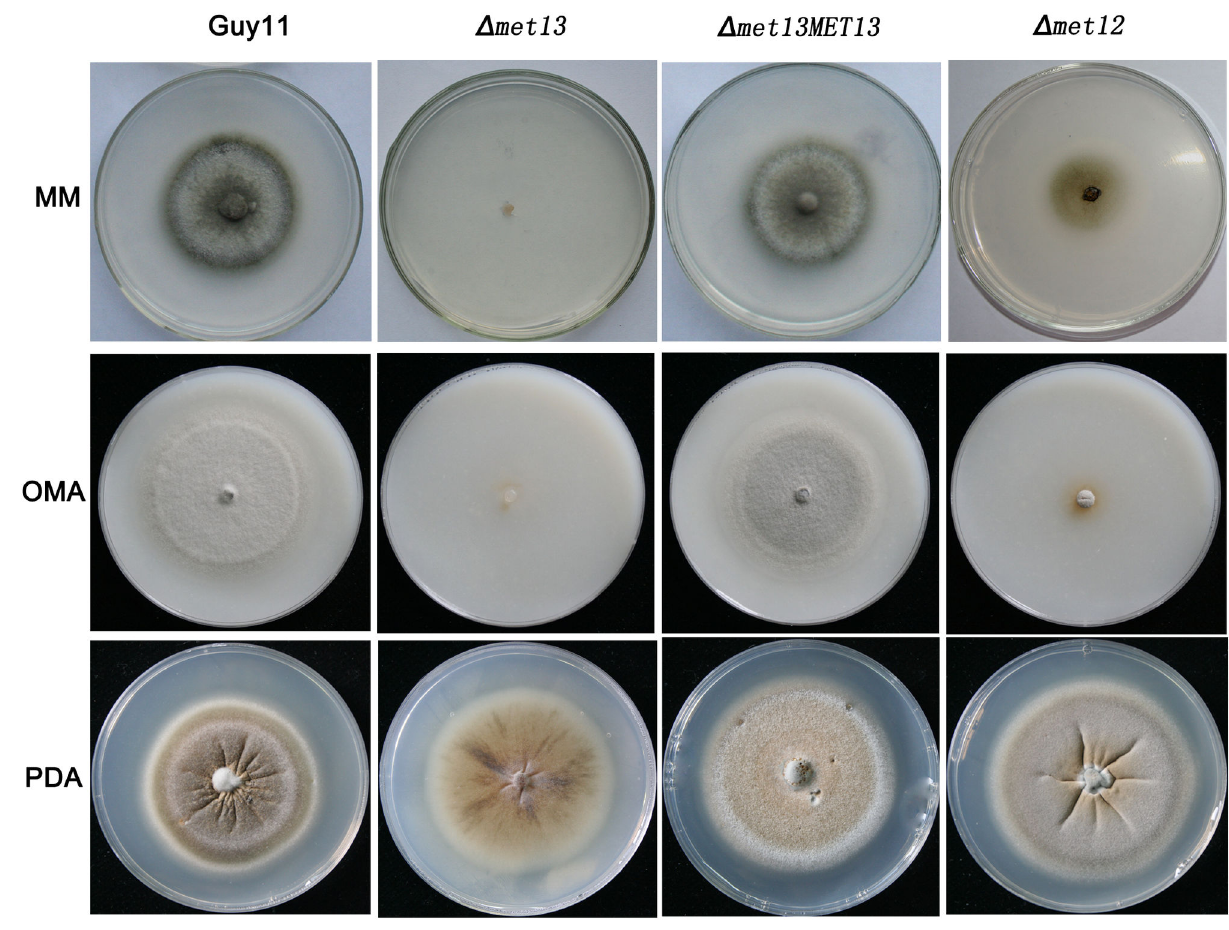
Figure 4. Growth of Δmet13 , Δmet13MET13 and Δmet12 on different medium. The wild-type strain Guy11, Δmet13 (K56), Δmet13MET13 (C3) and Δmet12 (K12-7) were grown on MM, OMA and PDA media at 25°C for 10 days. The Δmet13 mutant was unable to grow and the growth of the Δmet12 mutant was significantly restricted on MM and OMA medium. doi: